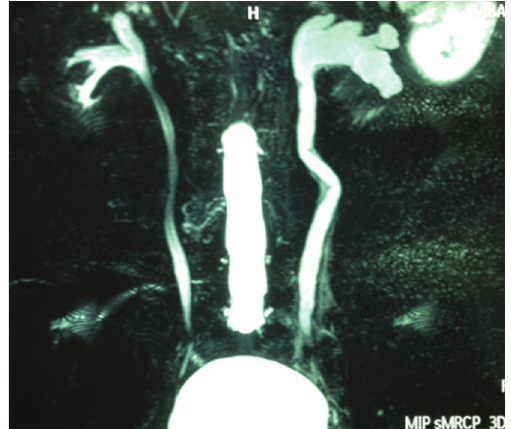
Figure 2: Coronal MR image demonstrating left-sided hydrouret- eronephrosis.